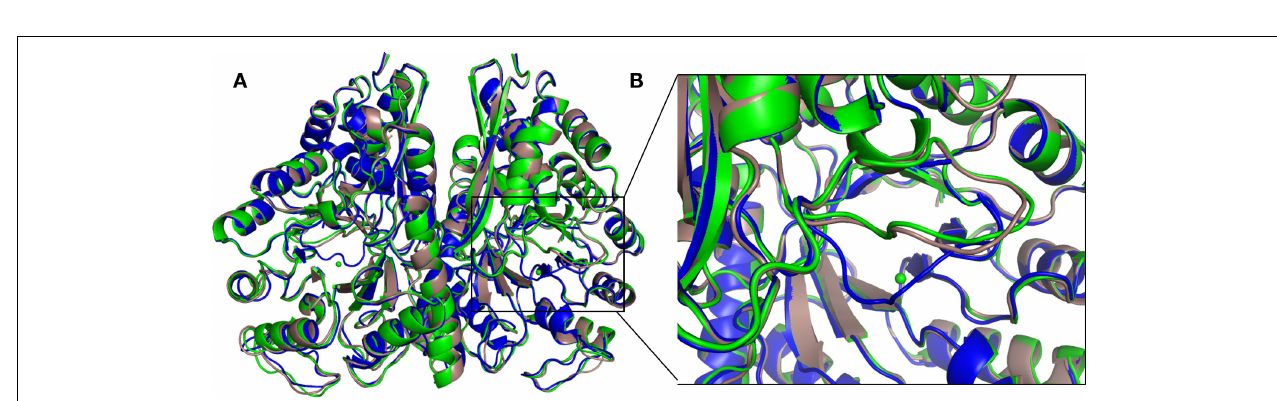
FIGURE 4 | Differences in the overall crystal structures of C. aurantiacus enolase . Superposition of apo (green), 2-PGA (gray), and PEP (blue) structures (A) . Close-up view of the L1 loop. In the PEP structure, the L1 loop is shown in close conformation (B) .